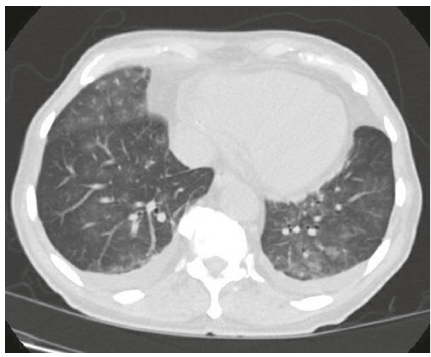
Figure 1: High-resolution CT showing bilateral ground glass opacities and bilateral pleural effusion. Table 1: Stages of Sarcoidosis according to chest X-ray